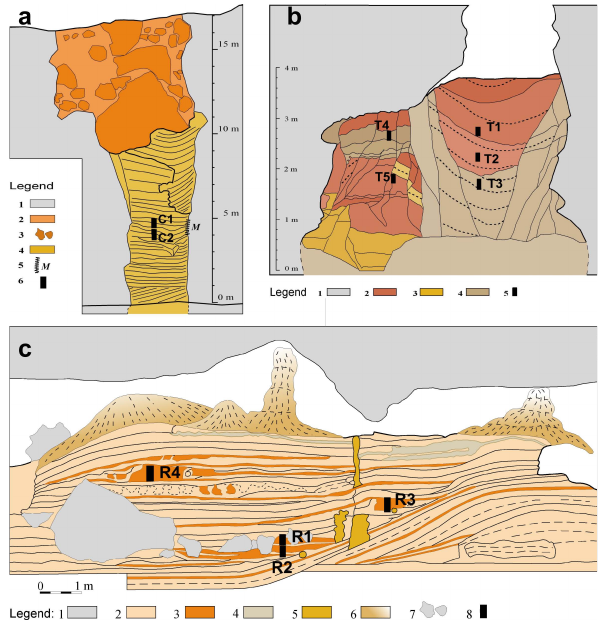
Fig. 2. Lithological sections at the studied sites: (a) a section in the filled horizontal cave passage cut by the ˇCrnotiˇce Quarry (the original section): 1=limestone, 2=flowstone mixed with red- dish clay, 3=large flowstone boulders, 4=allogenic laminated flu- vial sediment, 5=wall and sediment with tubes of Marifugia ca- vatica , 6=sampling points (C1–C2; modified from Bos´ak et al., 2004). (b) A section exposed in the Trhlovca Cave, several me- ters in thickness: 1=limestone, 2=reddish younger fill of clay, silt and fine sand, 3=clays lighter in color, with a higher sand proportion, 3=yellowish brown sandy clay, 4=brownish to ochre sandy clay, 5=sampling points (T1–T5; modified from Bos´ak et al., 2006); (c) Raˇciˇska peˇcina Cave section: 1=limestone 2=flowstone, 3=red clay, silt and sand, 4=brown clays with gravel and cave bear bones, 5=stalagmites in flowstone, 6=speleothems on the section surface, 7=collapsed limestone blocks, 8=sampling points (R1– R4; modified from Zupan Hajna et al., 2008b).